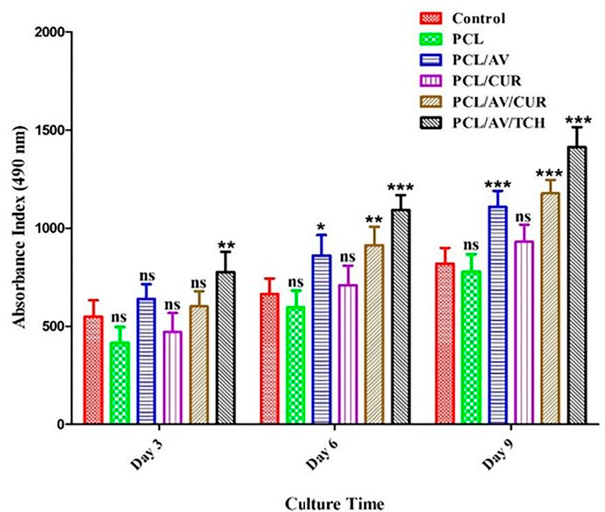
Figure 6. Proliferation of fibroblast on biocomposite nanofibrous scaffolds on day 3, 6, 9 in TCP, PCL, PCL/AV, PCL/CUR, PCL/AV/CUR and PCL/AV/TCH. ns: not significant, * p< 0.05, ** p< 0.01, *** p< 0.001.